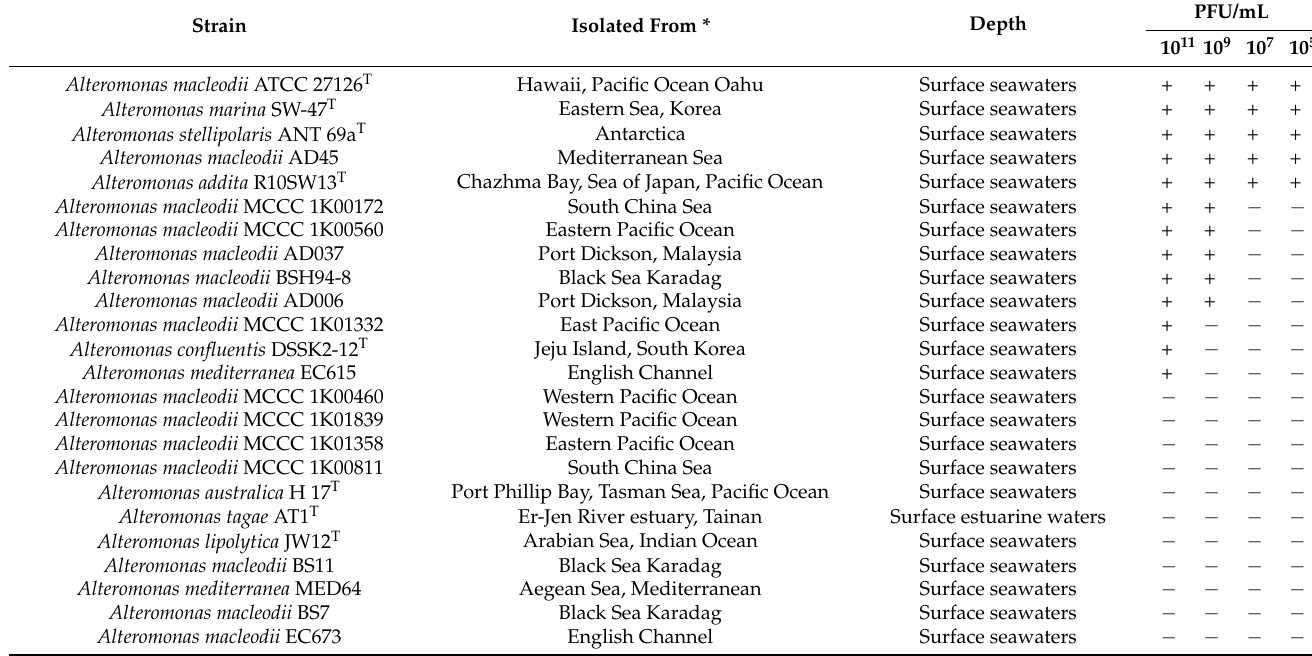
Table 2. The host range of vB_AmeP-R8W (R8W).